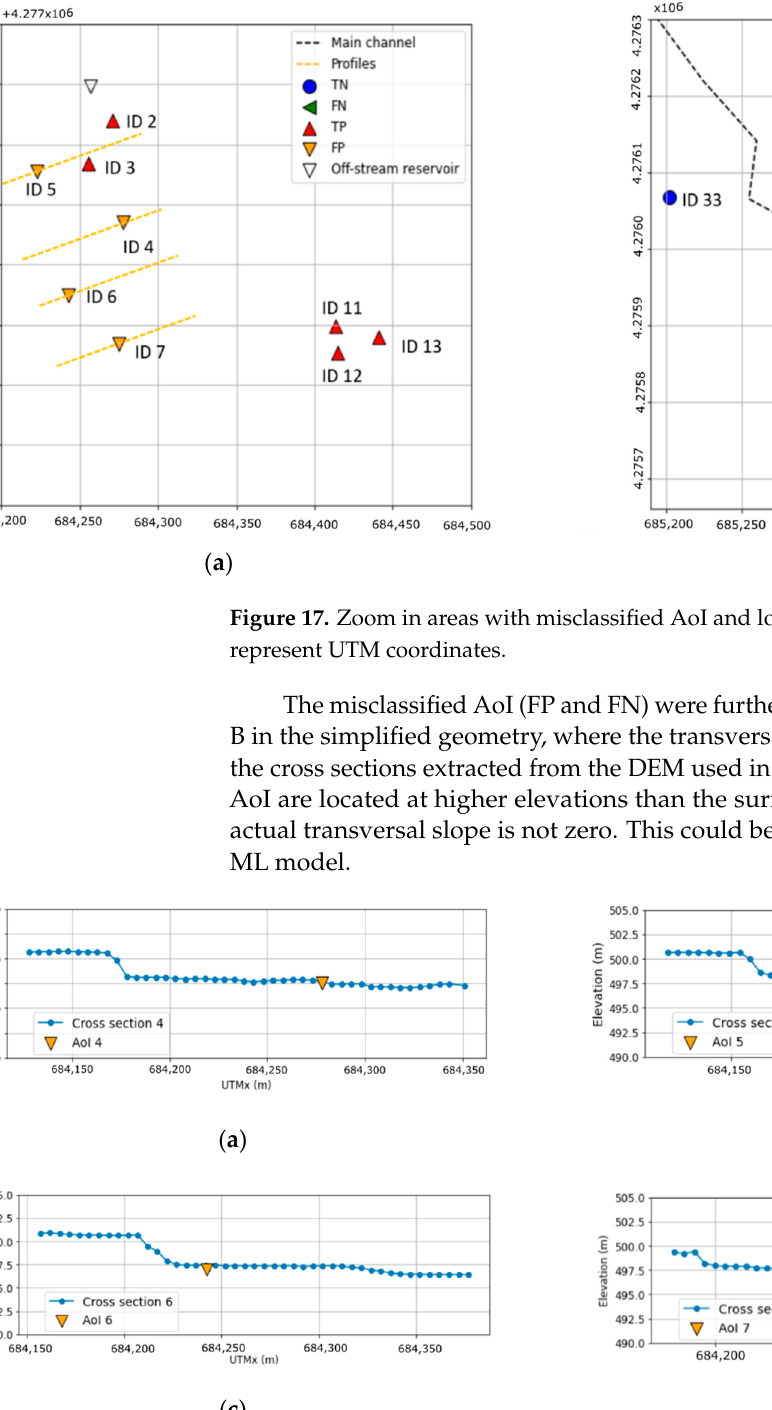
Figure 18. Cross-sections at the locations of the FP: ( a ) section 4; ( b ) section 5; ( c ) section 6; and ( d ) section 7.